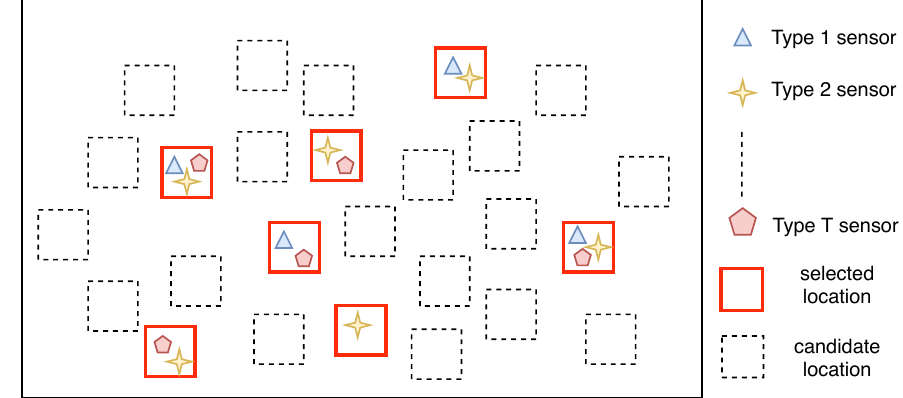
Figure 2. An example of the multi-type sensor placement